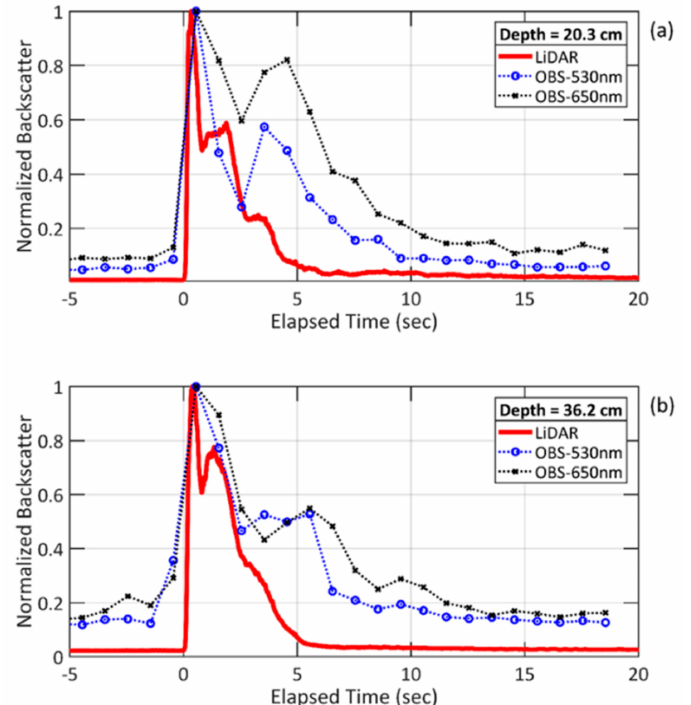
Figure 4. Time series of normalized backscatter of LiDAR and ECO Puck OBS sensors at depths of ( a ) 20.3 cm and ( b ) 36.2